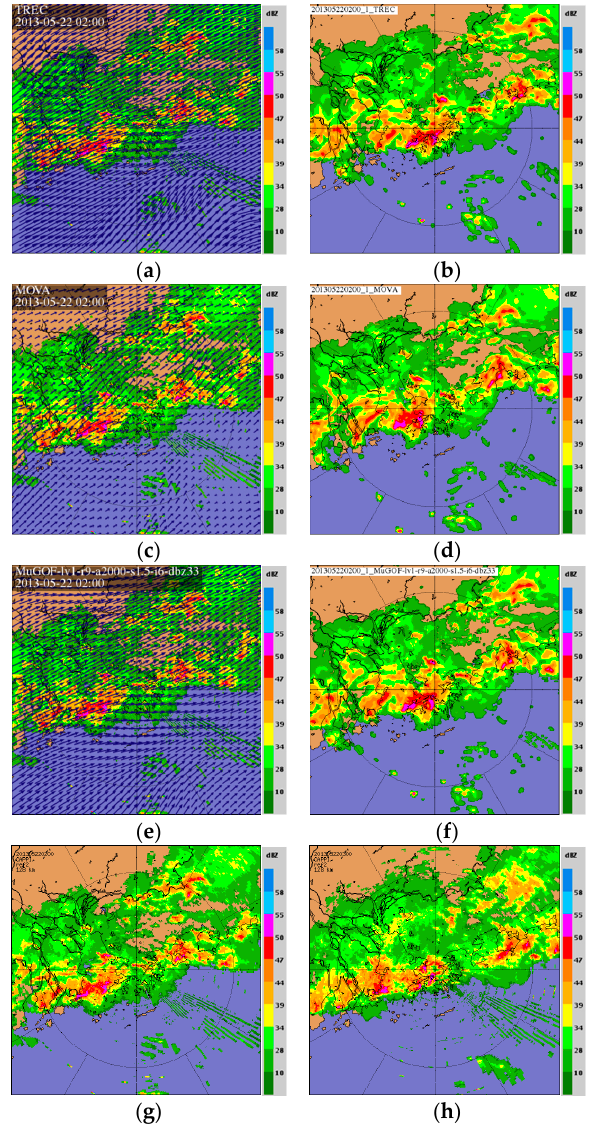
Figure 6. Reflectivity and motion fields based at 02:00 (HKT/UTC + 8) on 22 May 2013 (base time). ( a ) Reflectivity and motion field of TREC at base time; ( b ) Forecast reflectivity of TREC at 1 h from the base time; ( c ) Reflectivity and motion field of MOVA at base time; ( d ) Forecast reflectivity of MOVA at 1 h from the base time; ( e ) Reflectivity and motion field of ROVER at base time; ( f ) Forecast reflectivity of ROVER at 1 h from the base time; ( g ) Actual radar reflectivity at base time; and ( h ) Actual radar reflectivity at 1 h from the base time.